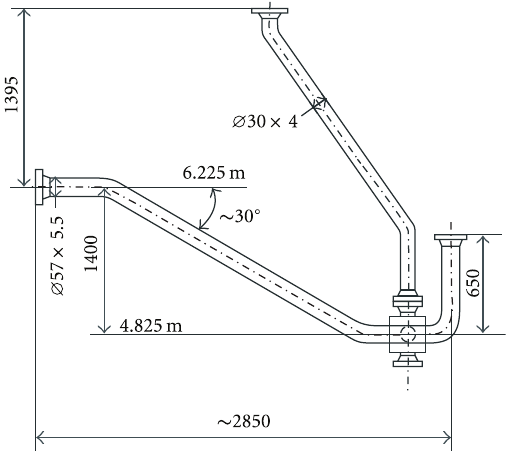
Figure 4: Hot leg with pressuriser surge